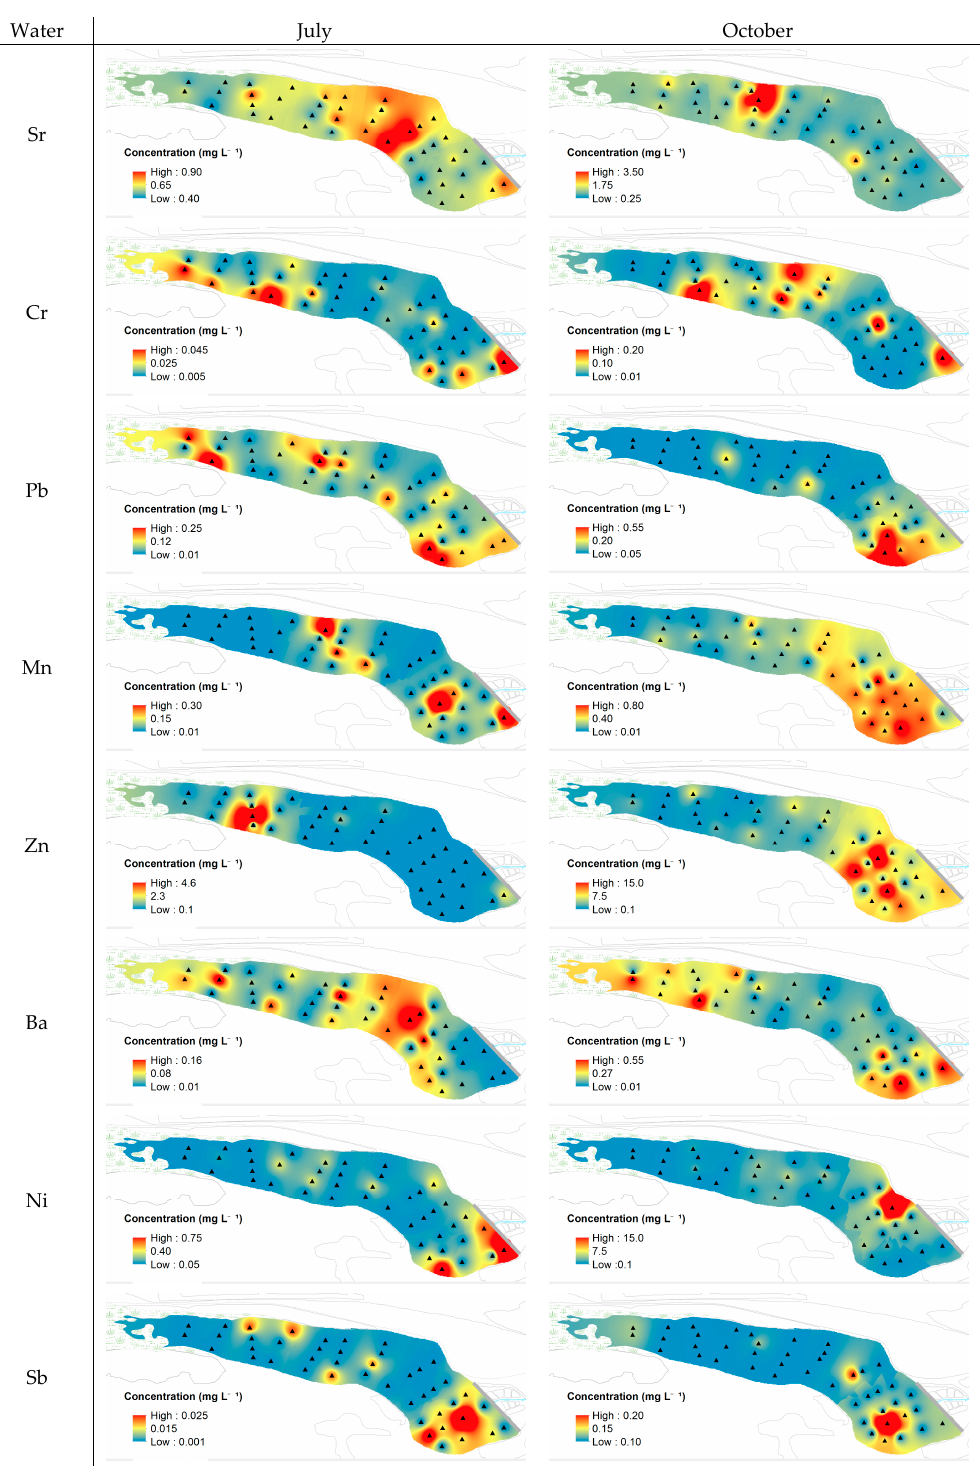
Figure 8. Spatial distribution of Sr, Cr, Pb, Mn, Zn, Ba, Ni, and Sb in water of Podu Iloaiei Dam Lake for July and October sampling sessions.